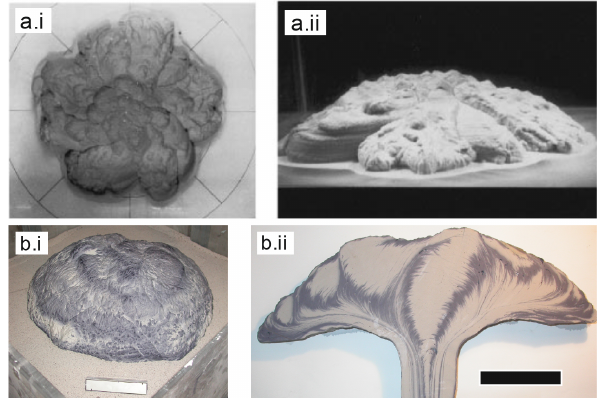
Figure 11. Studies of lava dome morphology: (a) analogue ex- periment by Griffiths and Fink (1997) of polyethylene glycol ex- truded from a point source imaged in (i) plan view and (ii) side view. (b) Photograph showing (i) external morphology and (ii) cross section through plaster of Paris analogue model of lava dome em- placement seeded with magnetic particles for AMS (scale bars are 10cm long, photos courtesy of Prokop Zavada. See also Zavada et al.,